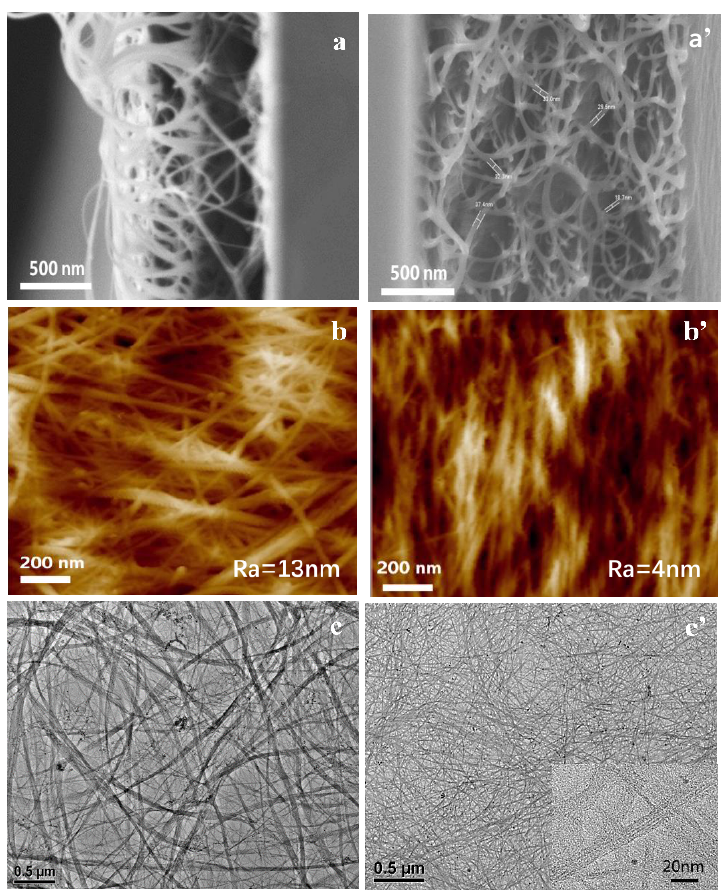
Figure 4. The freeze-fractured cross section SEM images and AFM topographic images of mix-SWNTs / rr-P3DDT composite films ( a , b ) and sc-SWNTs / rr-P3DDT composite films ( a’ , b’ ) with 50 wt% SWNTs; TEM images of SWNTs / rr-P3DDT composite films; ( c ) and sc-SWNTs / rr-P3DDT composite film ( c’ ) with 50 wt% SWNTs dissolved in toluene solvent.